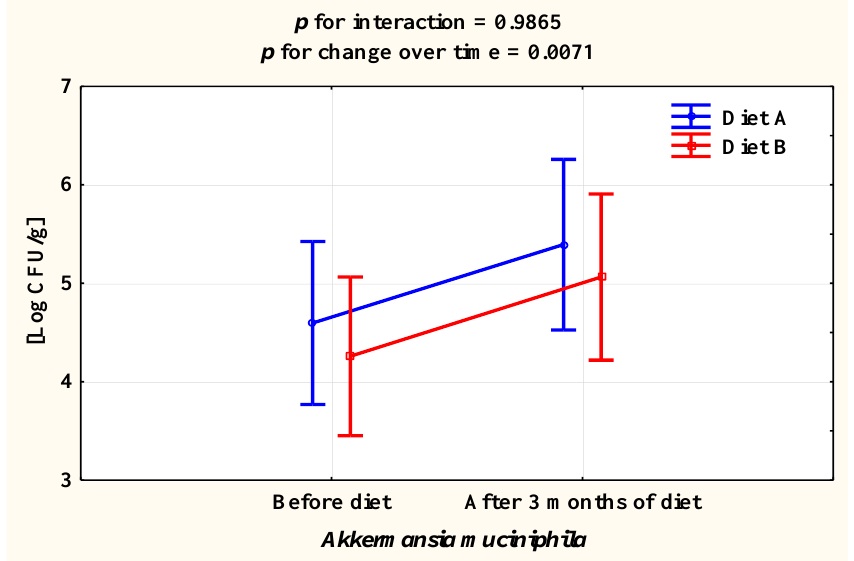
Figure 3. Change in the number of A. muciniphila in the stool samples of the women studied. Table 4. Intestinal microbiota of study participants before and after 3 months of dietary change.